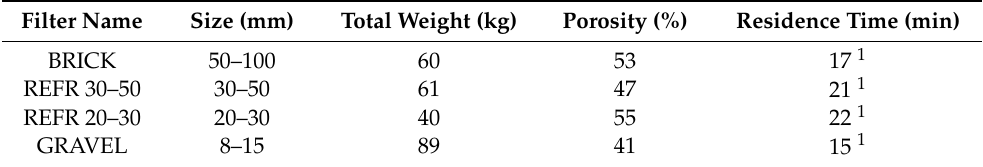
Table 1. Composition and characteristics of filters.